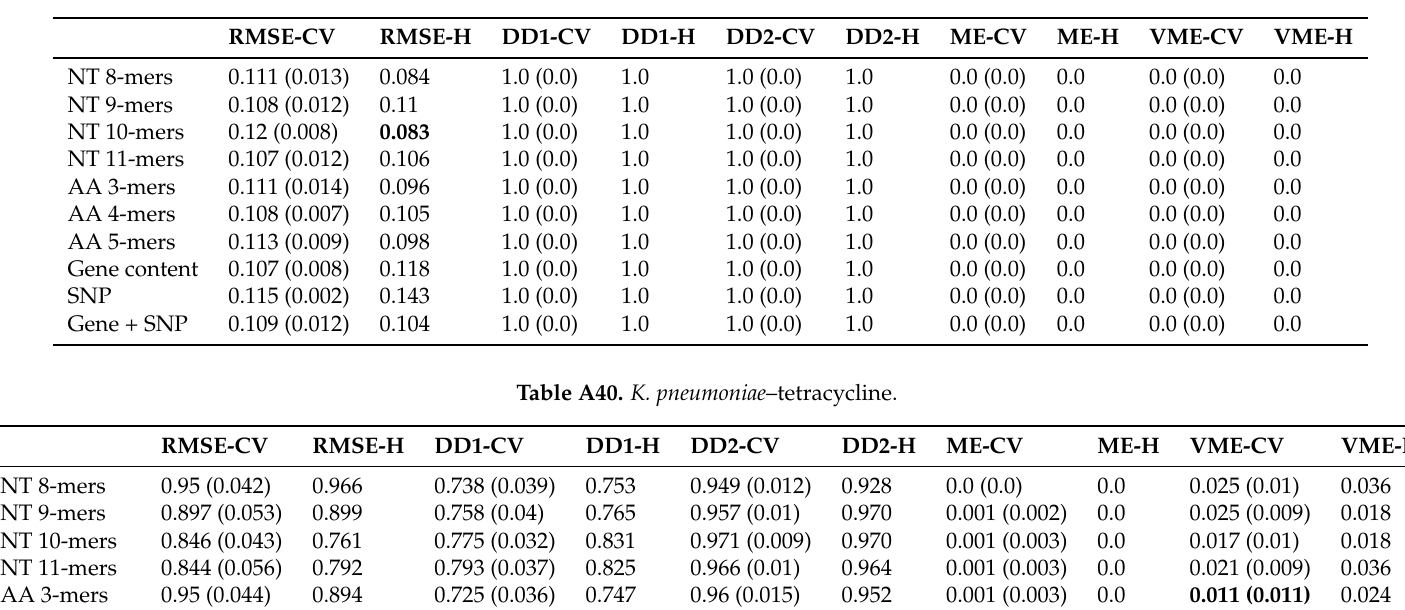
Table A39. K. pneumoniae –ampicillin.